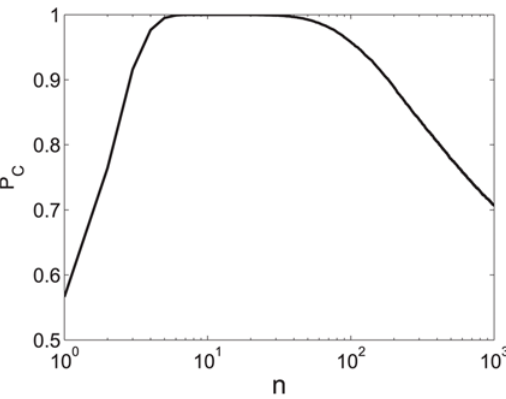
Figure 5. Performance of the n - tWTA readout in a 2AFC discrimination task in a two-column model. The probability of correct discrimination of the n - tWTA readout is shown as function of n . The probability of correct discrimination was estimated by averaging over 10 5 realizations of the neural stochastic response in an IHPP model for spike time distribution as defined in equation (23) with: N ~ 100 ,